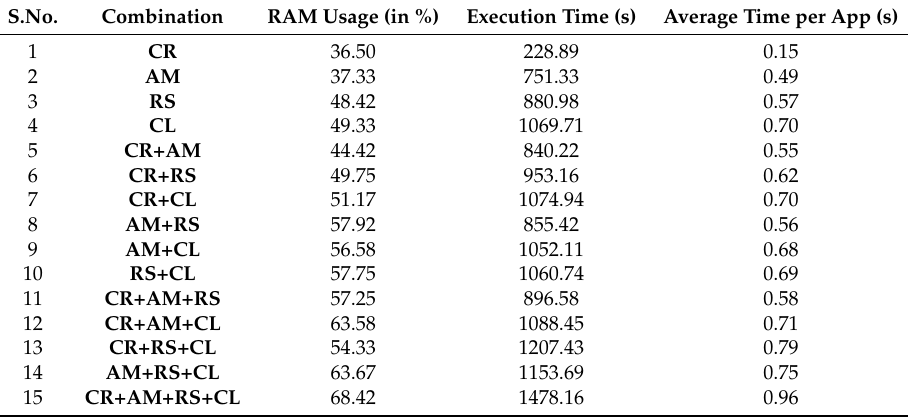
Table 6. A comparison of runtime metrics to showcase resource usage and execution time